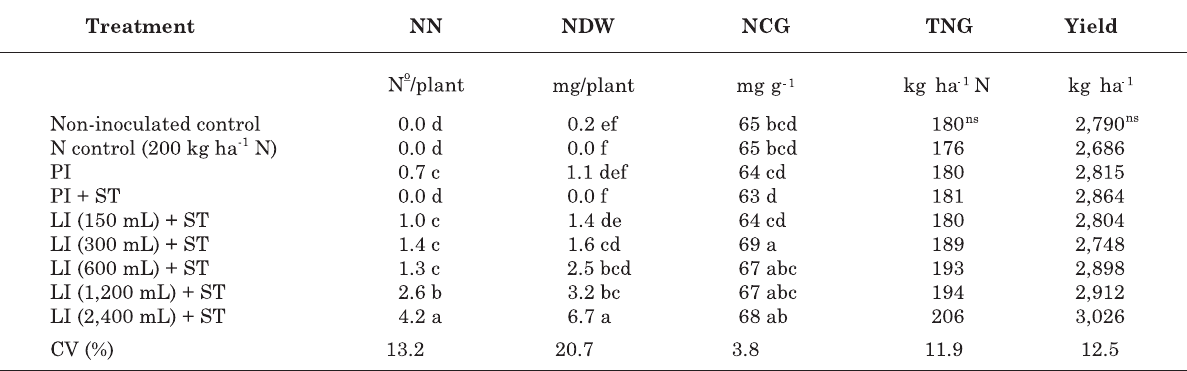
Table 5. Nodule number (NN) and dry weight (NDW) at the V4 stage, N grain content (NGC) at the R2 stage, total N grain content (TNG), and grain yield at the harvest of soybean inoculated with peat (PI) or liquid (LI) inoculant, with or without seed treatment (ST) with fungicides and micronutrients (1) . Experiment conducted in Avaré, São Paulo, in the 2000/2001 growing season, in a soil treated with inoculant for the first time (< 10 1 cells g -1 of soil)